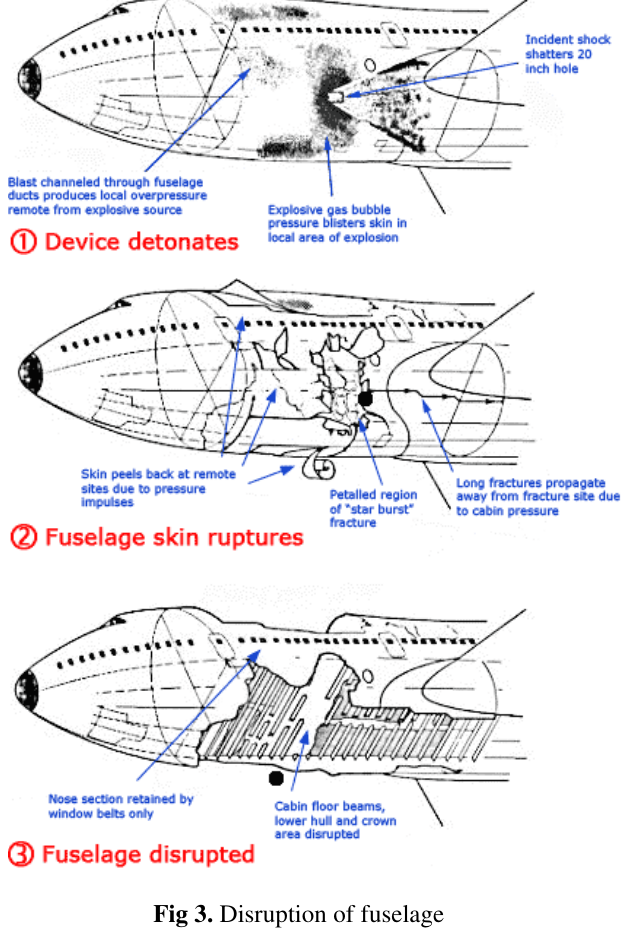
Fig 3. Disruption of